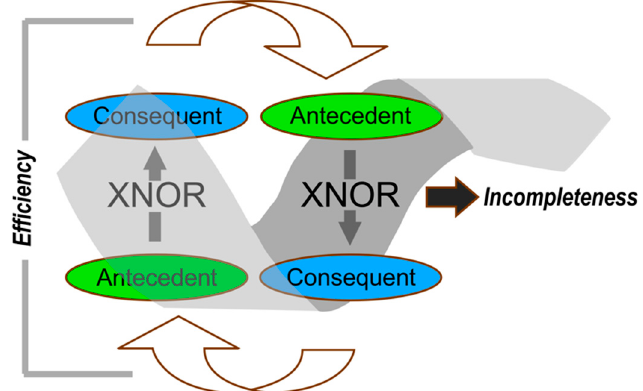
Figure 8. Elements of reciprocally ‐ coupled gating. Two coupled logical XNOR gates are joined head to tail into a single gate, showing the coupling of antecedent and consequent “statements”, which assume different meanings in each of the examples described in Figures 2–4 and 7. That coupling is brought about by interchanging the antecedent and consequent. This type of coupling constitutes self ‐ reference, hence creates incompleteness. The two XNOR filters together greatly damp unintended variants of the antecedent and consequent, hence reduce dissipation.